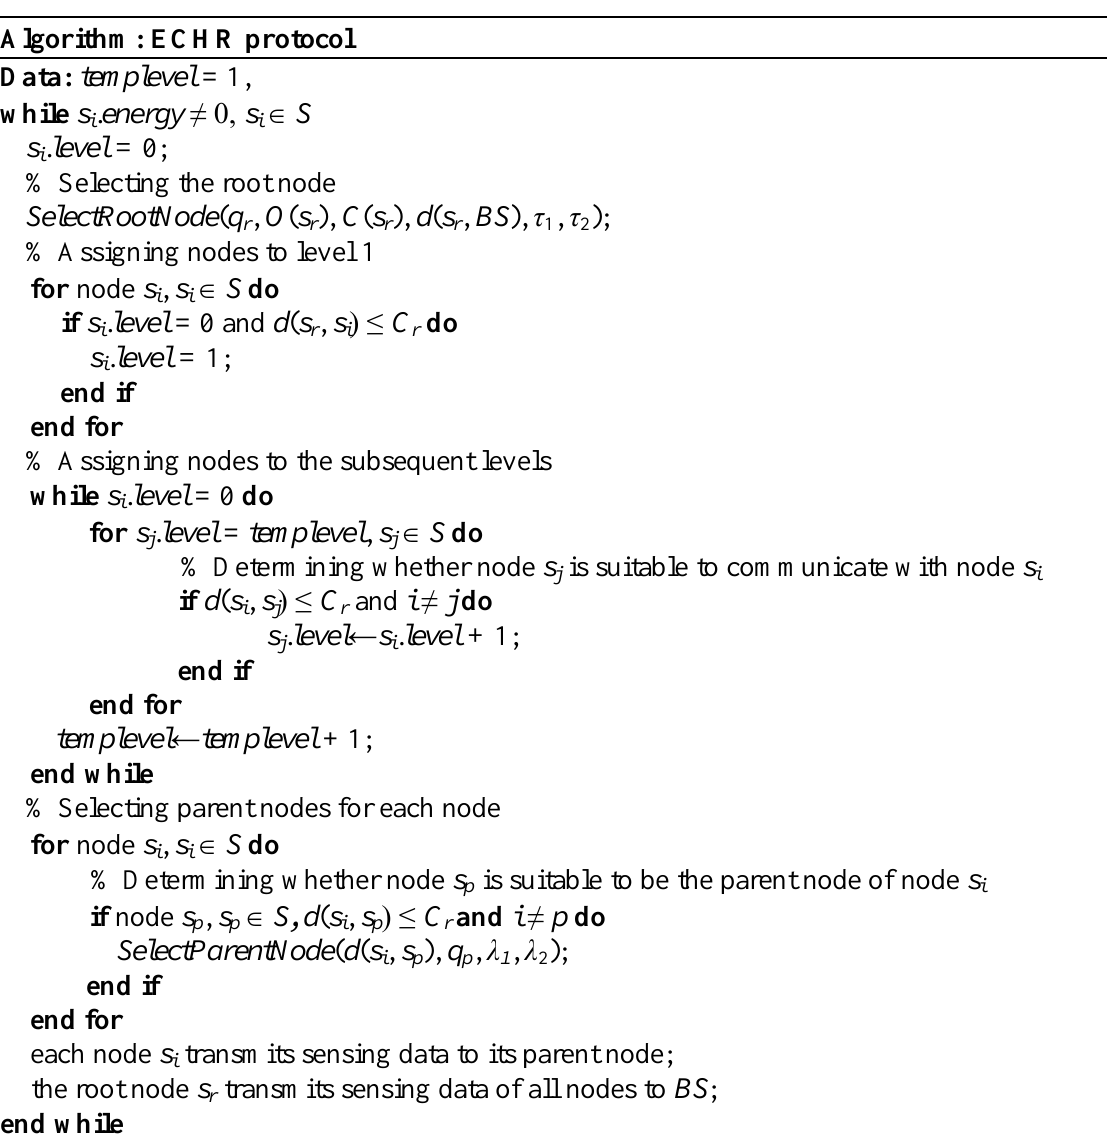
Figure 2. Pseudo code of the proposed ECHR